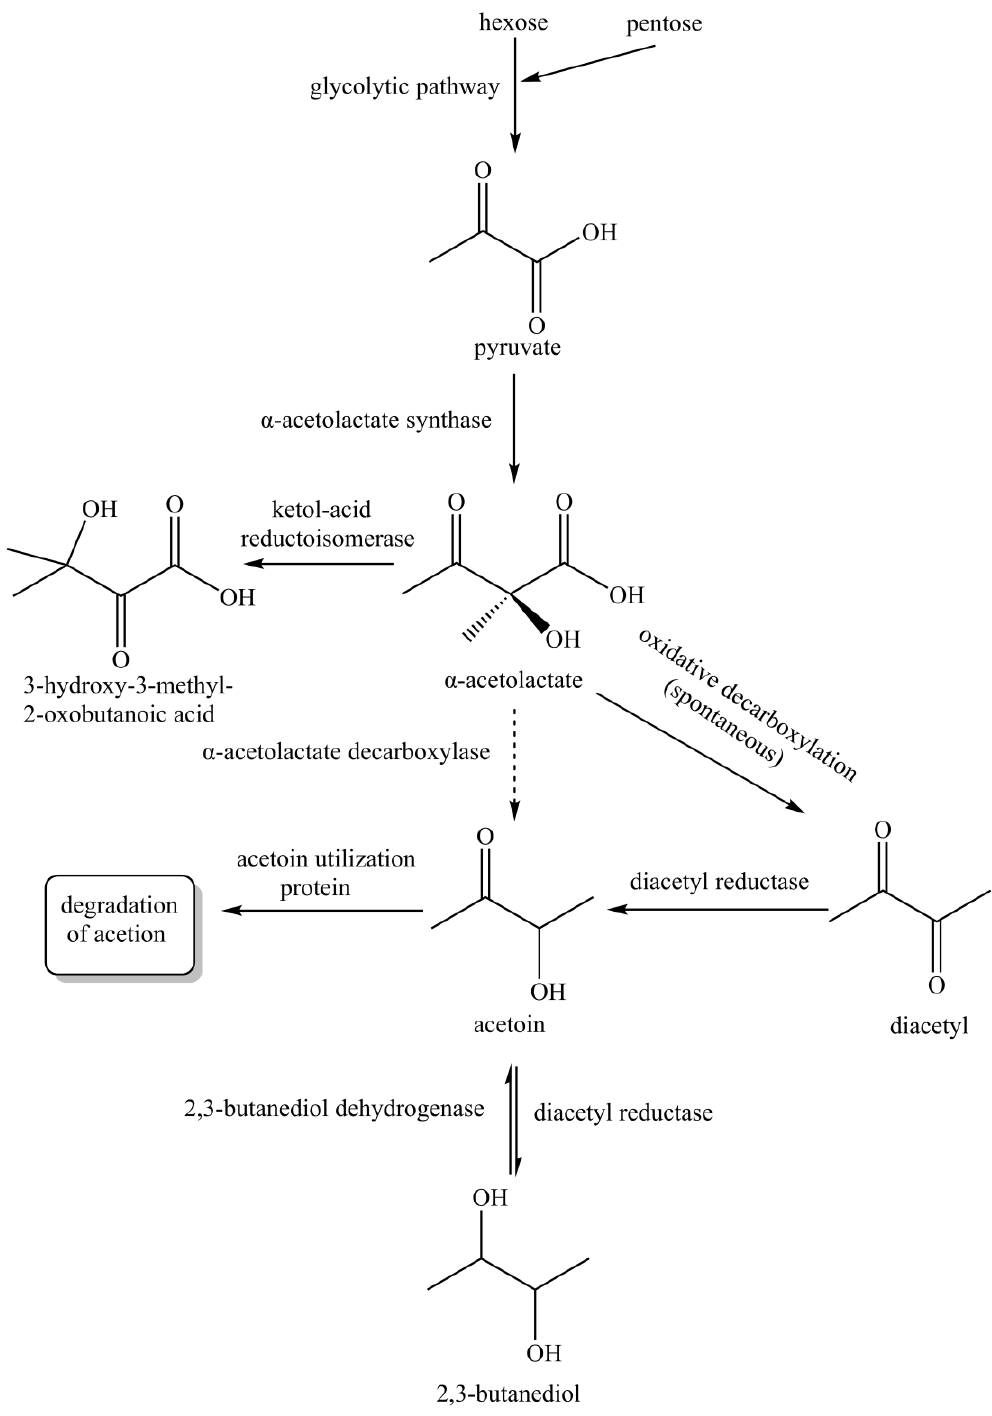
Figure 4. The metabolic pathway of acetoin in Rummeliibacillus sp. TYF-LIM-RU47. Most of the reported separated natural strains producing acetoin are Bacillus subtilis.